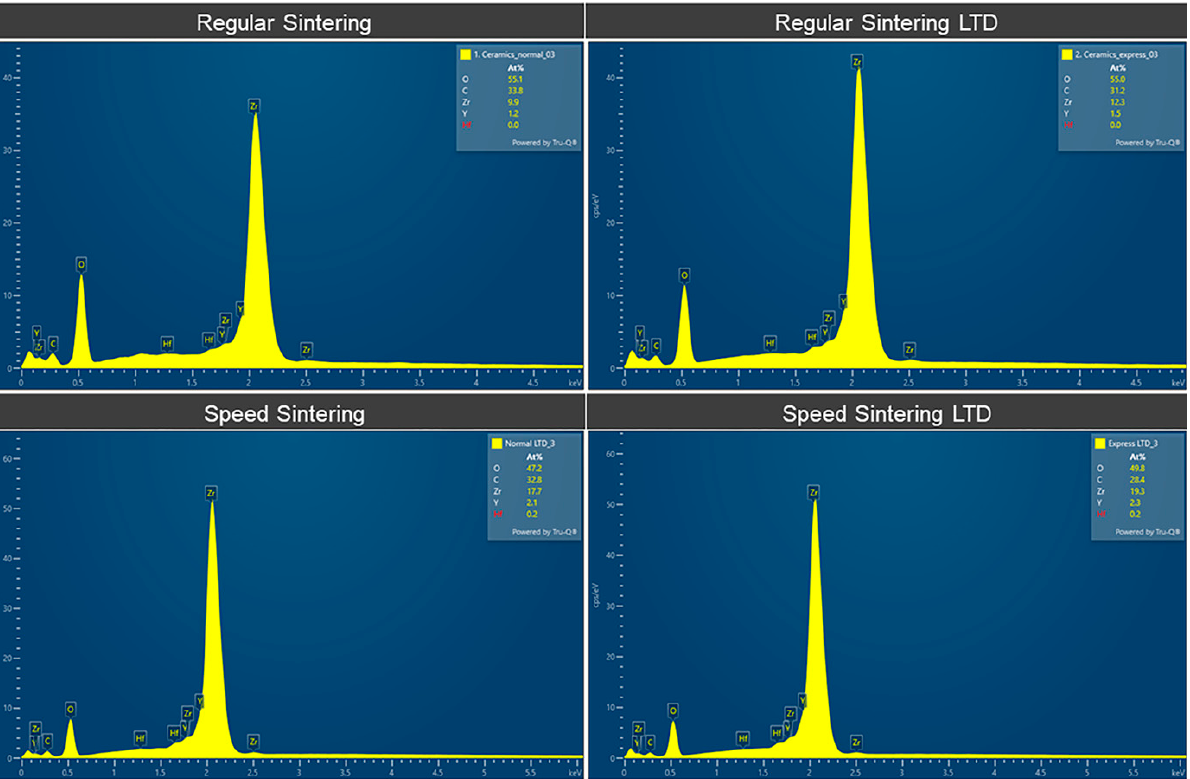
Figure 6. EDS Spectra of the zirconia specimens for the regular speed sintering and speed sintering with and without low-temperature degradation (LTD). Table 3. Results of the EDS elemental analysis of the zirconia specimens for the regular speed sin- tering and speed sintering with and without low-temperature degradation (LTD).